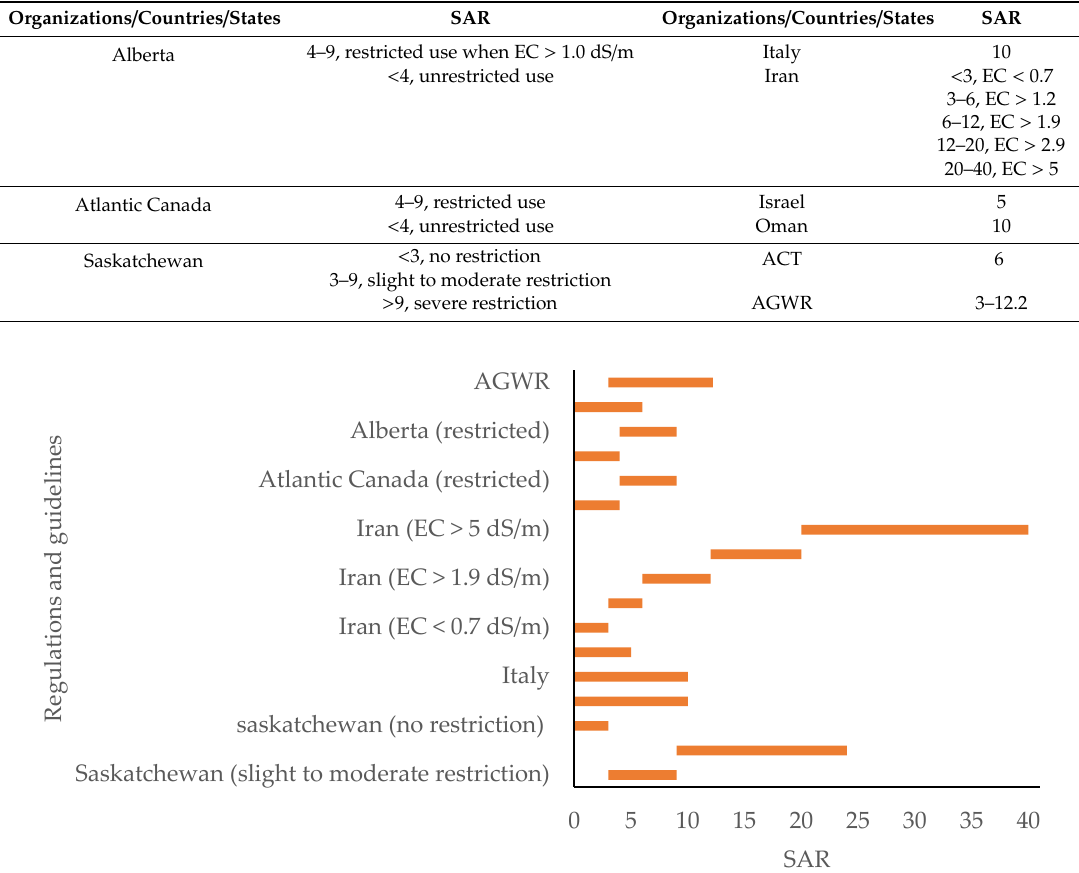
Figure 4. Required sodium adsorption ratio (SAR) ranges in agricultural water reuse regulations and guidelines.